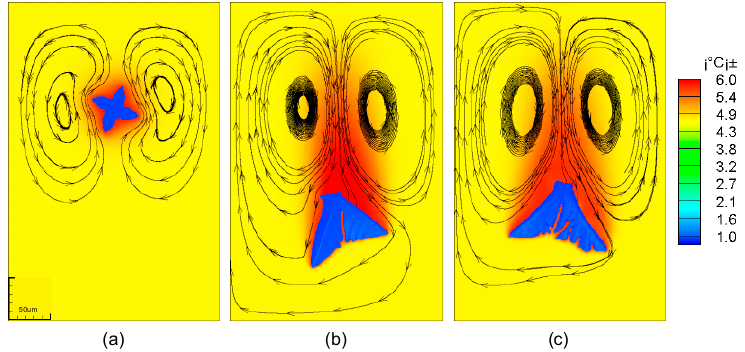
Figure 7. Flow field distribution in the process of dendrite falling; ( a ) stationary dendrites; ( b ) falling dendrites; ( c ) falling and rotating dendrites.